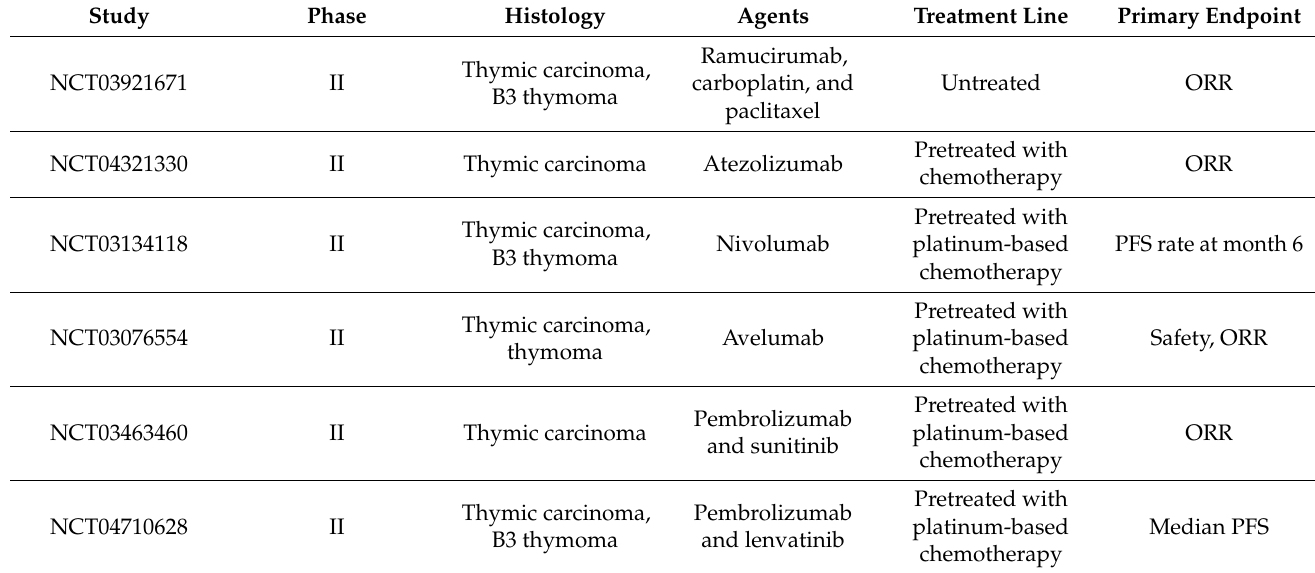
Table 3. Ongoing clinical trials for thymic